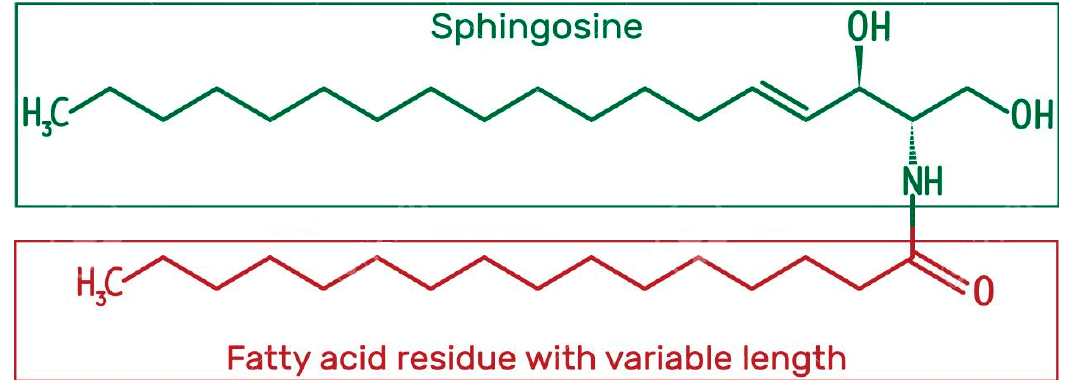
Figure 3. Ceramide structure.